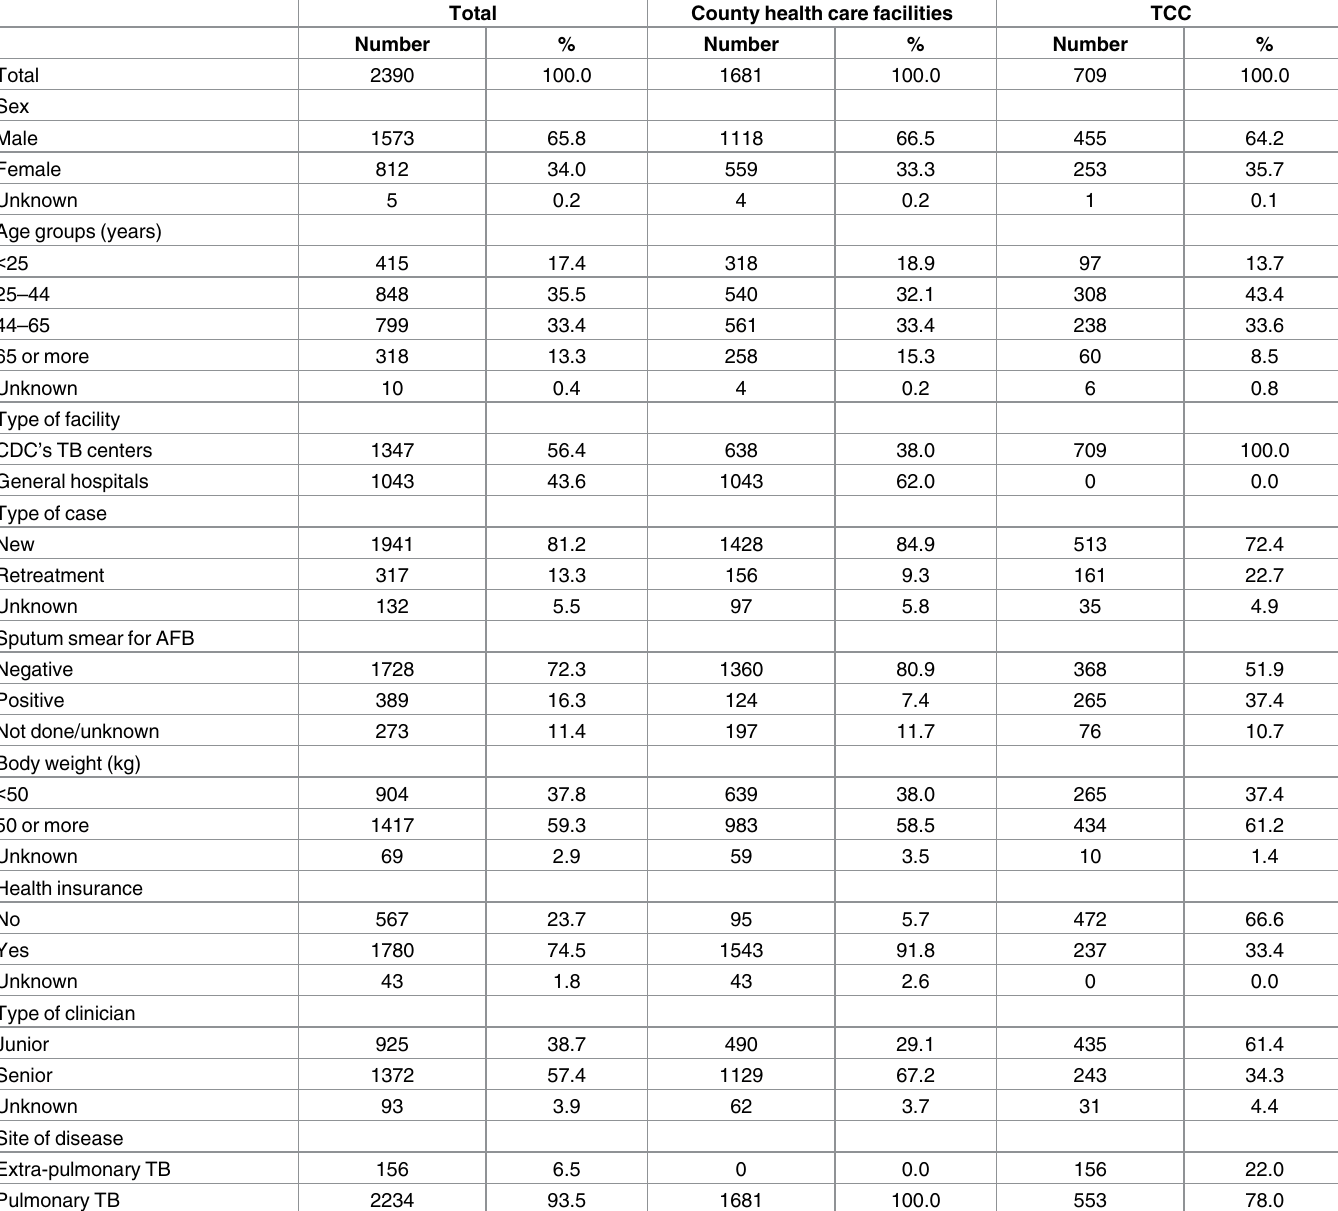
Table 1. Demographics of the study population, by county health care facilities (CDC’s TB center or designated TB hospital) and Tuberculosis Clinical Center